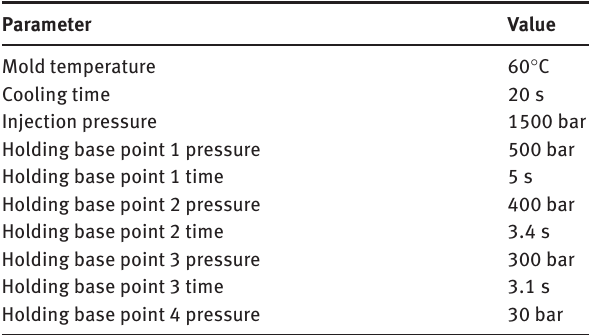
Table 5 Constant parameters of injection molding process.